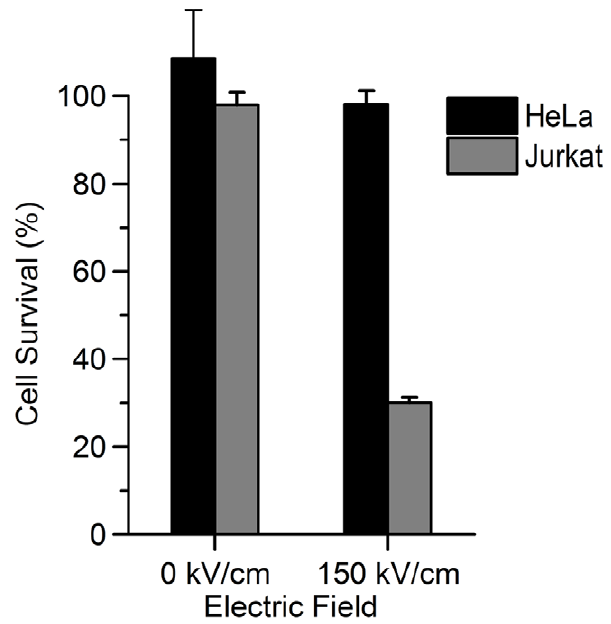
Figure 11. Dose-dependent changes in survival are retained in a heterogeneous cell mixture. Jurkat and HeLa cells were exposed in mixture to a 100 pulse train of 10-ns EP at 150 kV/cm, resulting in efficient killing of Jurkat but little effect on HeLa cells. (mean + / 2 s.e, n=3).